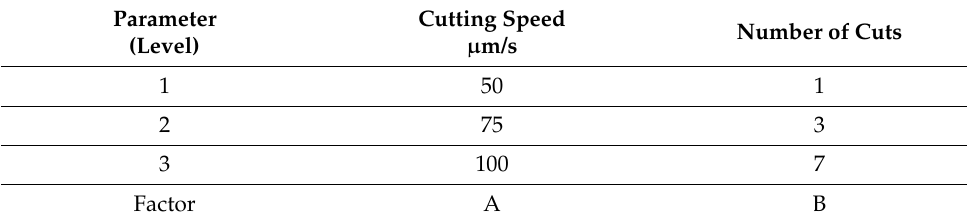
Figure 4. Wire electric discharge machining (WEDM) set up. Table 2. Process parameters and their levels. Table 2. Process parameters and their levels.